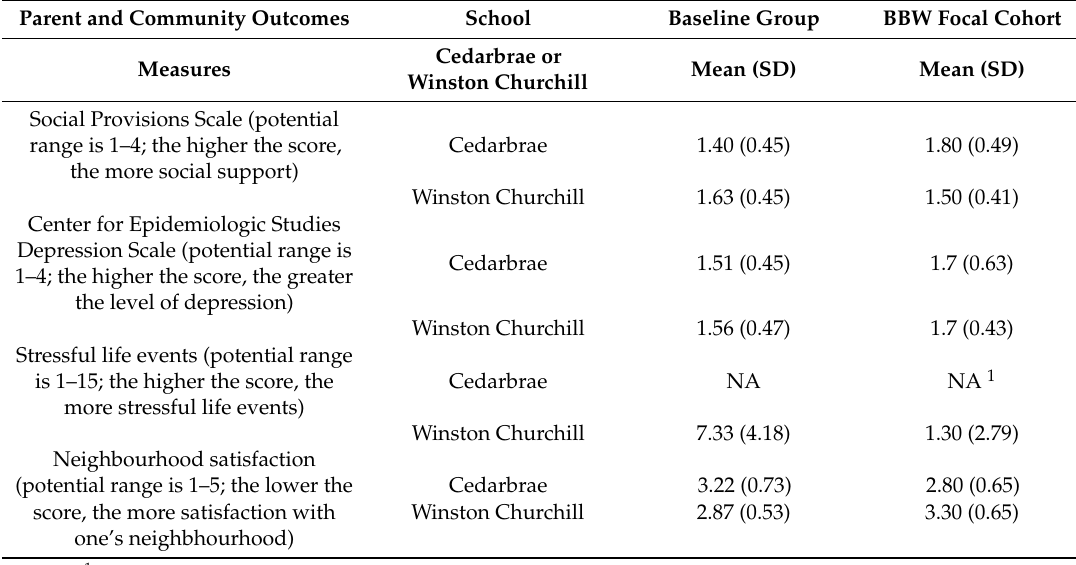
Table 3. Comparison of Baseline and BBW Focal Cohort Samples on Parent and Community Outcomes. Parent and Community Outcomes School Baseline Group Cedarbrae Measures